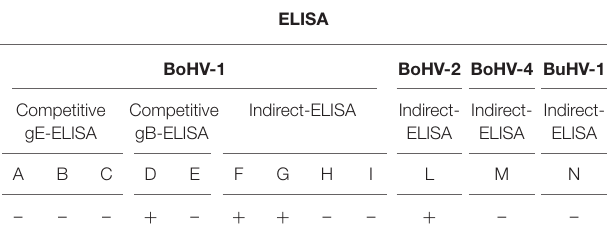
TABLE 1 | Antibody response obtained from different ELISA tests against BoHV-1, BoHV-2, BoHV-4, and BuHV-1 in the serum sample obtained from a performance station in Central